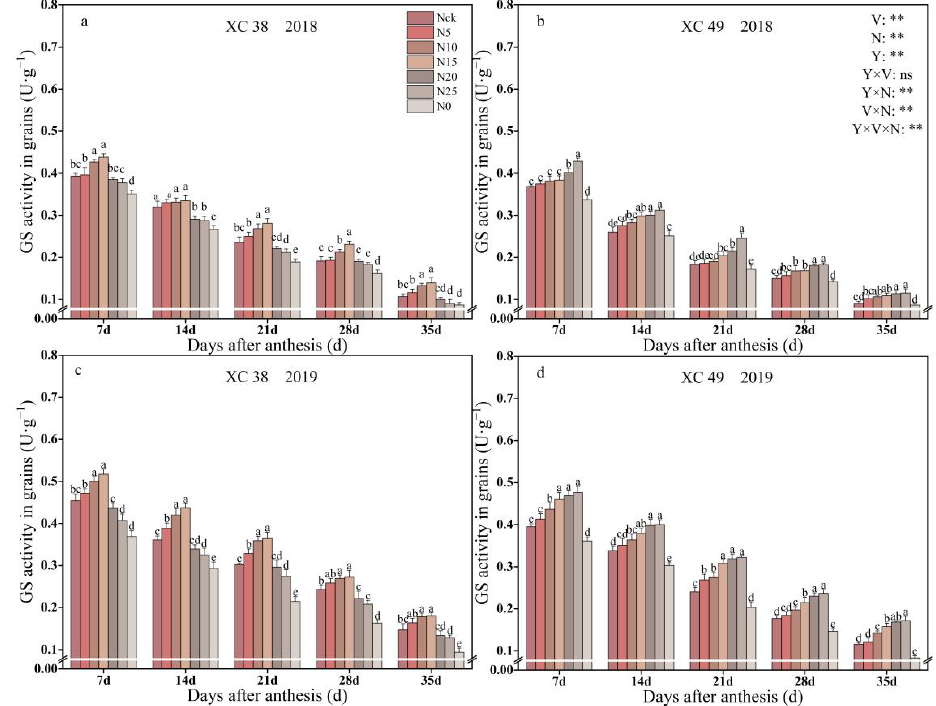
Figure 3. Effects of different nitrogen treatments on GS activity in grain in 2018 and 2019. ( a ) GS activity of XC 38 grains in 2018; ( b ) GS activity of XC 49 grains in 2018; ( c ) GS activity of XC 38 grains in 2019; ( d ) GS activity of XC 49 grains in 2019. XC 38: Xinchun 38; XC 49: Xinchun 49; Nck: 300 kg hm − 2 , N5: 285 kg hm − 2 , N10: 270 kg hm − 2 , N15: 255 kg hm − 2 , N20: 240 kg hm − 2 , N25: 225 kg hm − 2 , N0: 0 kg hm − 2 ; V: Variety, N: Nitrogen, Y: Year. ** represents significant differences at 0.01 level; ns indicates insignificant differences. Different lowercase letters in the figure represent significant differences at 0.05 level.